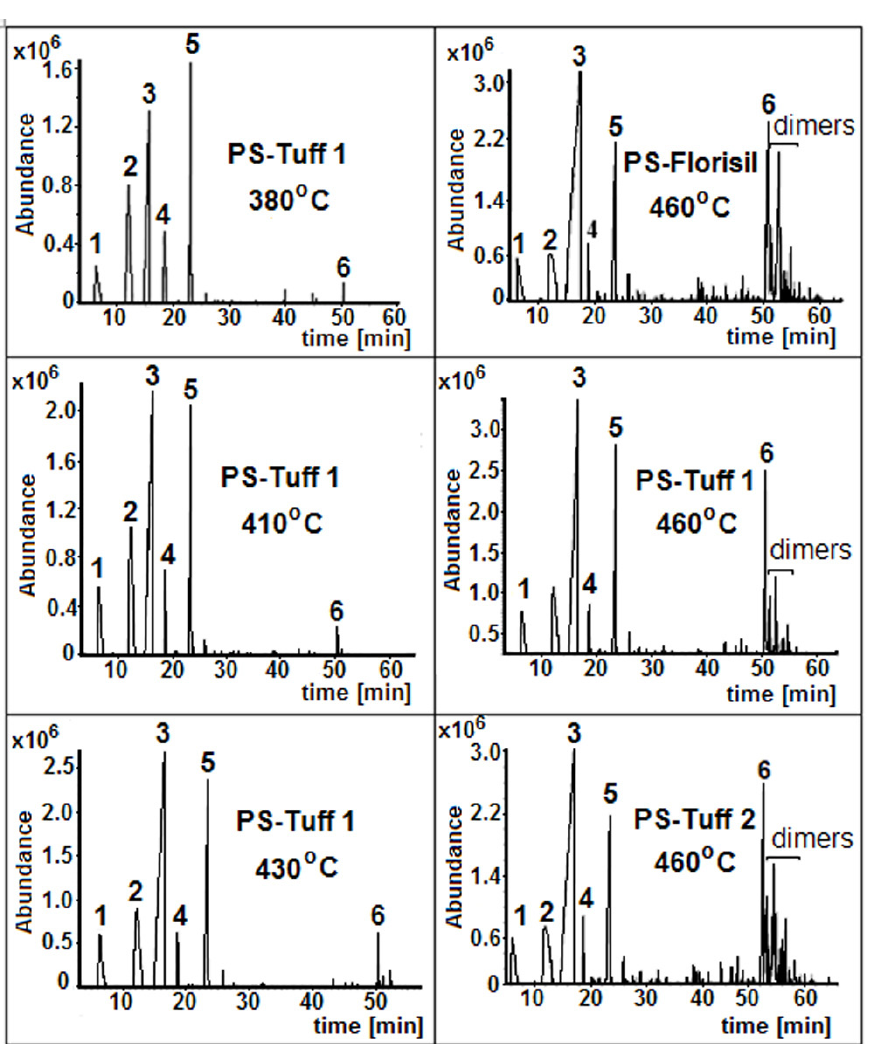
Figure 7. GC-MS chromatograms of some liquid products obtained by thermal and catalytic degradation of PS.